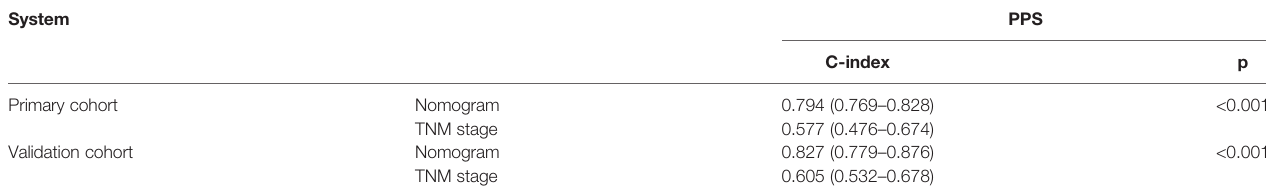
TABLE 3 | Comparisons of the C-index with the nomogram and 8th TNM stage system in the primary cohort and validation cohorts.